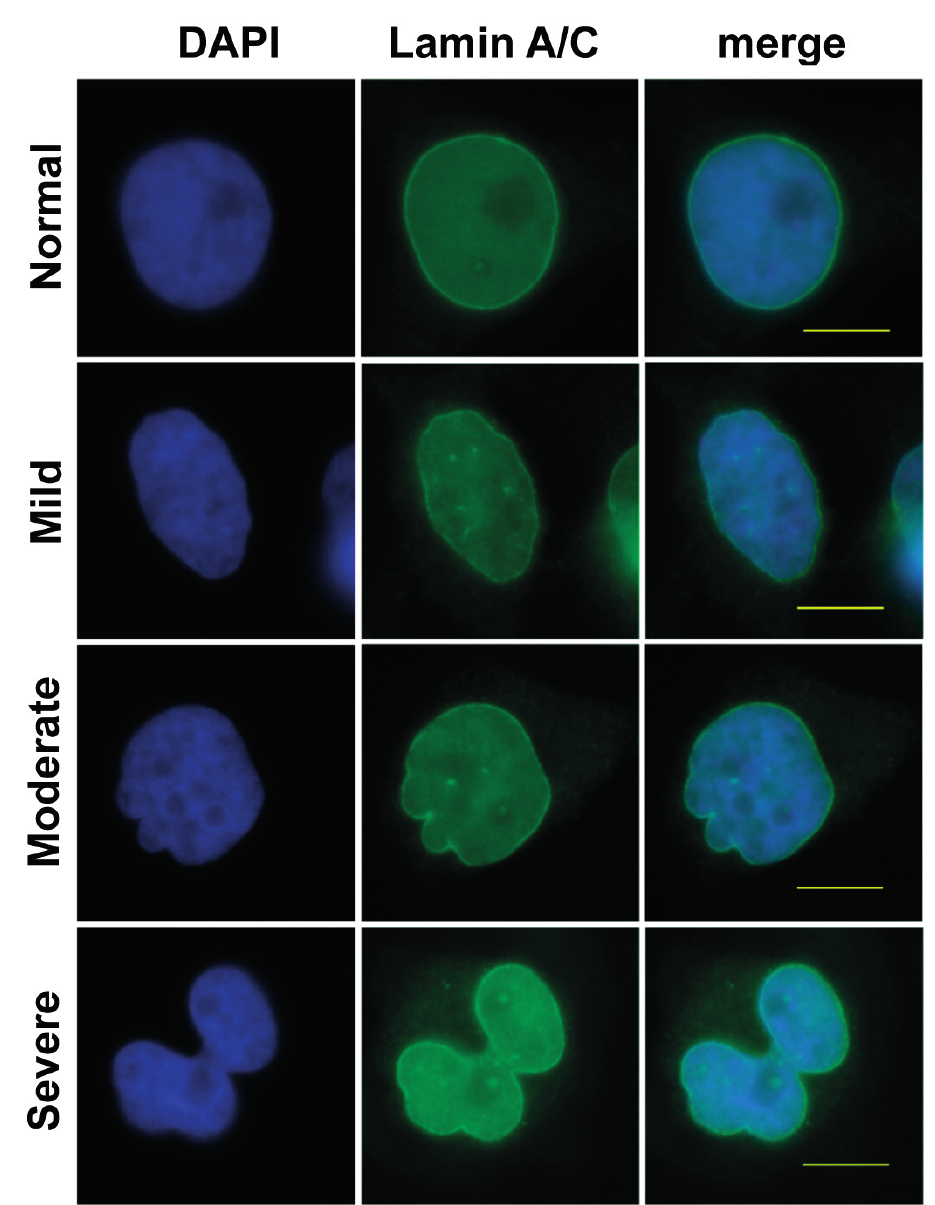
Figure 3. Four categories of nuclear morphology. Nuclear shape of RNAi treated HeLa cells as seen by Lamins A/C (green), DNA (blue) and placed into four categories ranging from “Normal” round/oval nuclei; nuclei having few or “Mild” abnormal features; nuclei with obvious or “Moderate” amount of abnormal features; “Severe” with numerous abnormal features and overall non-round/oval shape. See methods for details. Scale bar, 5 μ